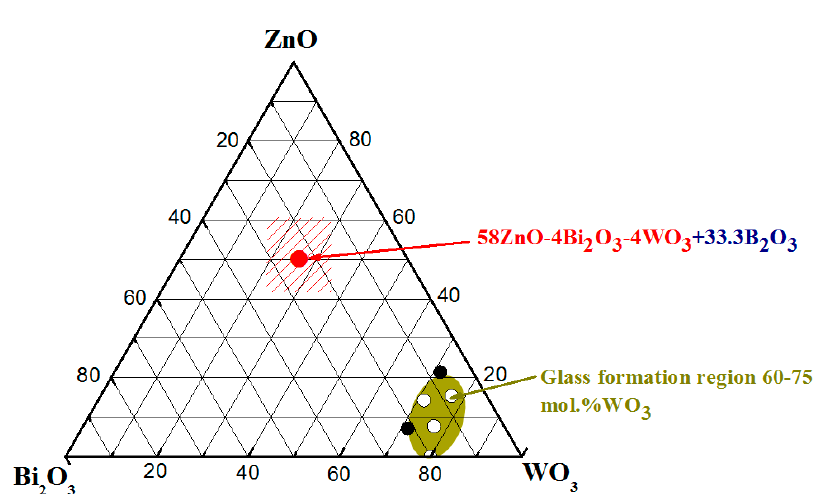
Figure 2. Ternary diagram of ZnO-Bi 2 O 3 -WO 3 system, where ( ○ ) indicate glasses and ( ● ) crystalline phases; ( ● ) 58ZnO:4Bi 2 O 3 :4WO 3 :33.3B 2 O 3 .